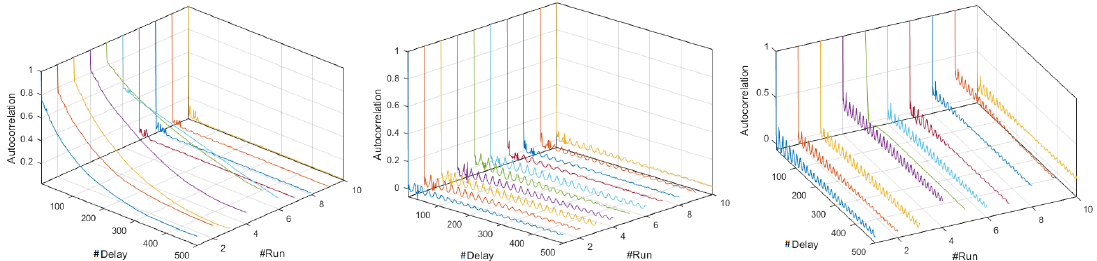
Figure 6. SAFs with different characteristics for DigiMesh network at 19,200 bauds. From left to right: Coordinator Node, Node 2, and Node 4.